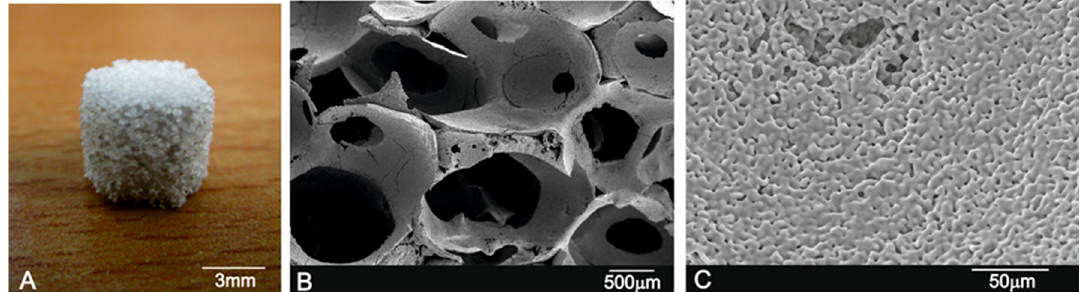
Figure 1. ( A ) Optical image of the Si ‐α TCP scaffolds obtained by the polymer replication method; ( B ) A low ‐ magni fi cation SEM view of the scaffolds showing interconnectivity and high porosity; ( C ) The high ‐ magni fi cation view of the scaffold reveals a well ‐ distributed microporosity.